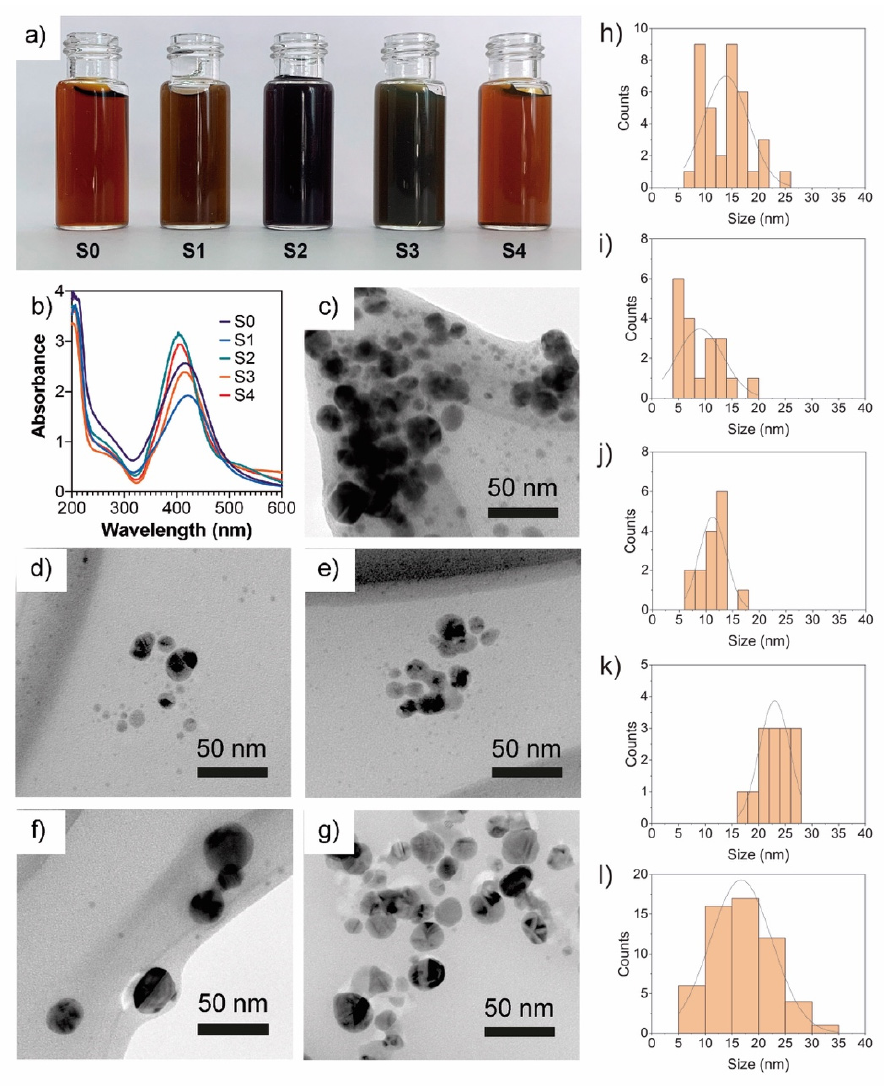
Figure 3. Photography ( a ) of AgNPs dispersions, UV-vis spectra ( b ) of AgNPs obtained using different mycelia-free aqueous extract fractions (all nanoparticle solutions were diluted in water 1:20), TEM images ( c – g ), and histograms ( h – l ) of AgNPs synthesized with S0, S1, S2, S3, and S4 extract fractions, respectively. Table 1. Characterization of the AgNPs obtained using different mycelia-free aqueous extract frac- tions.